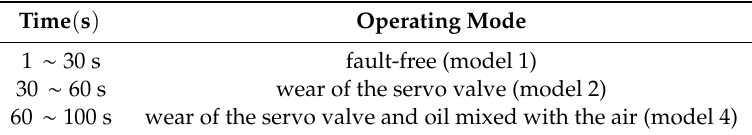
Table 3. The operating modes of HA in simulation 2.